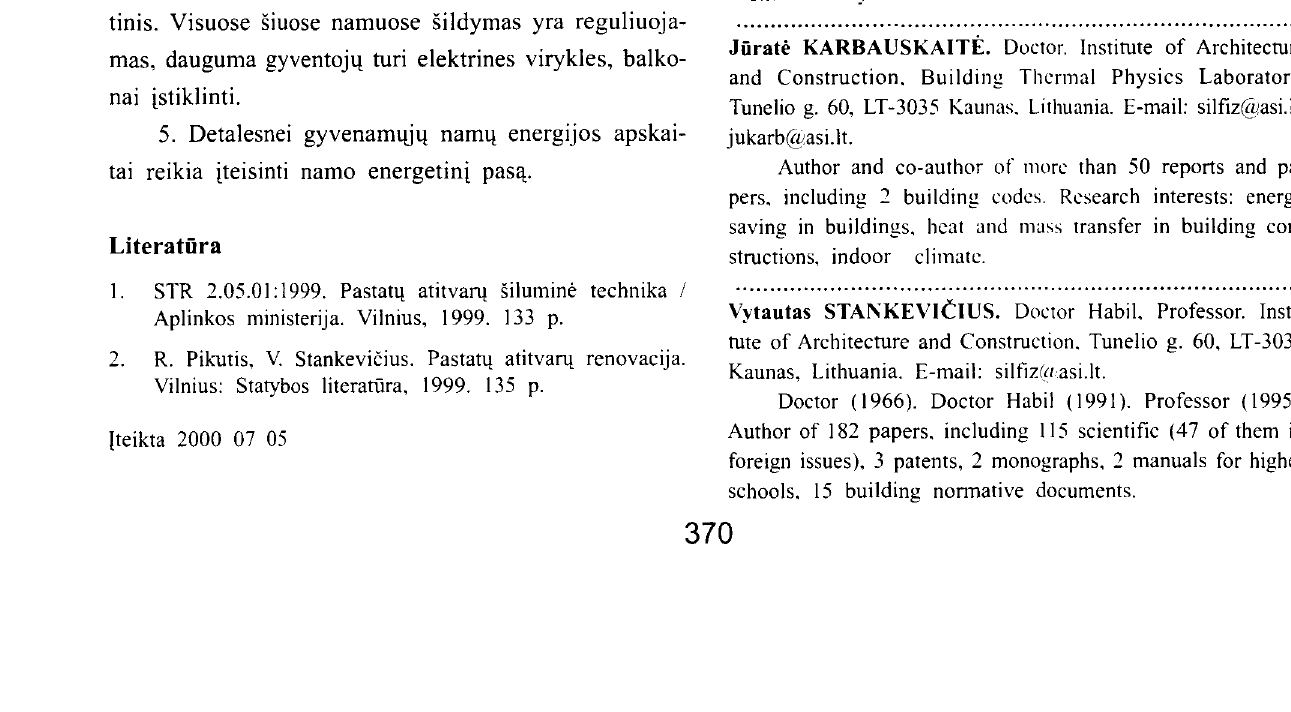
4. Daugumoje daugiaauksCil! pastatl! projektinis si lumines energijos poreikis, apskaiCiuotas pagal